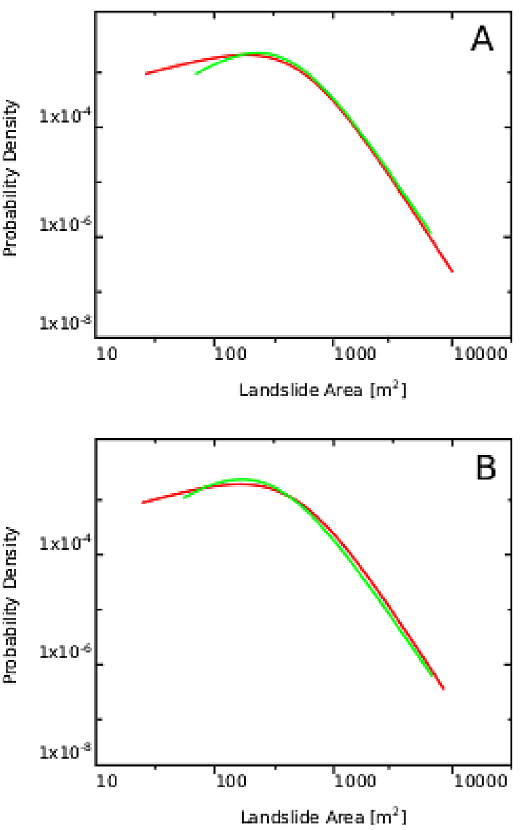
Figure 7. Dependence of landslide probability densities p ( y axis) on landslide area A L ( x axis) for the two event landslide invento- ries. Curves show double Pareto density functions (Stark and Hov- ius, 2001) for the photo-interpreted (PI, green) inventory shown in Fig. 3a, and for the semi-automatic (SA, red) inventory shown in Fig. 3b. (A) Density functions for the original (complete) invento- ries. (B) Density functions for the modified (reduced) inventories. See text for